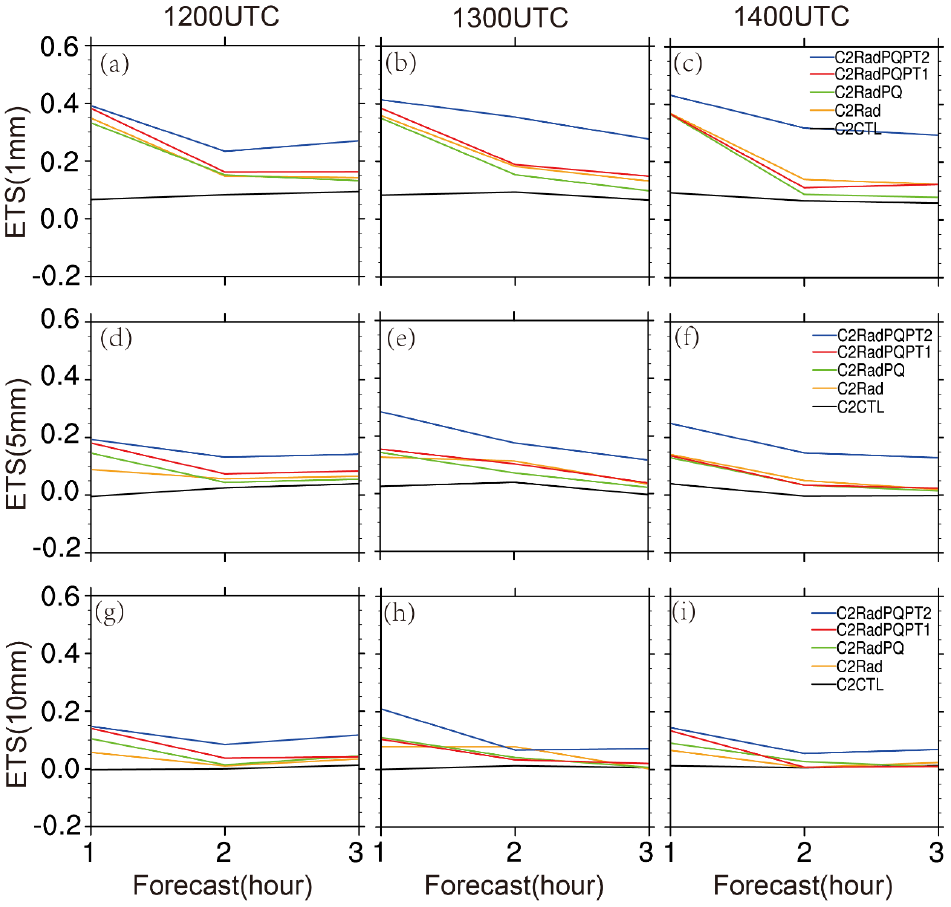
Figure 15. Same as in Figure 10, but for 4 July, 2018.